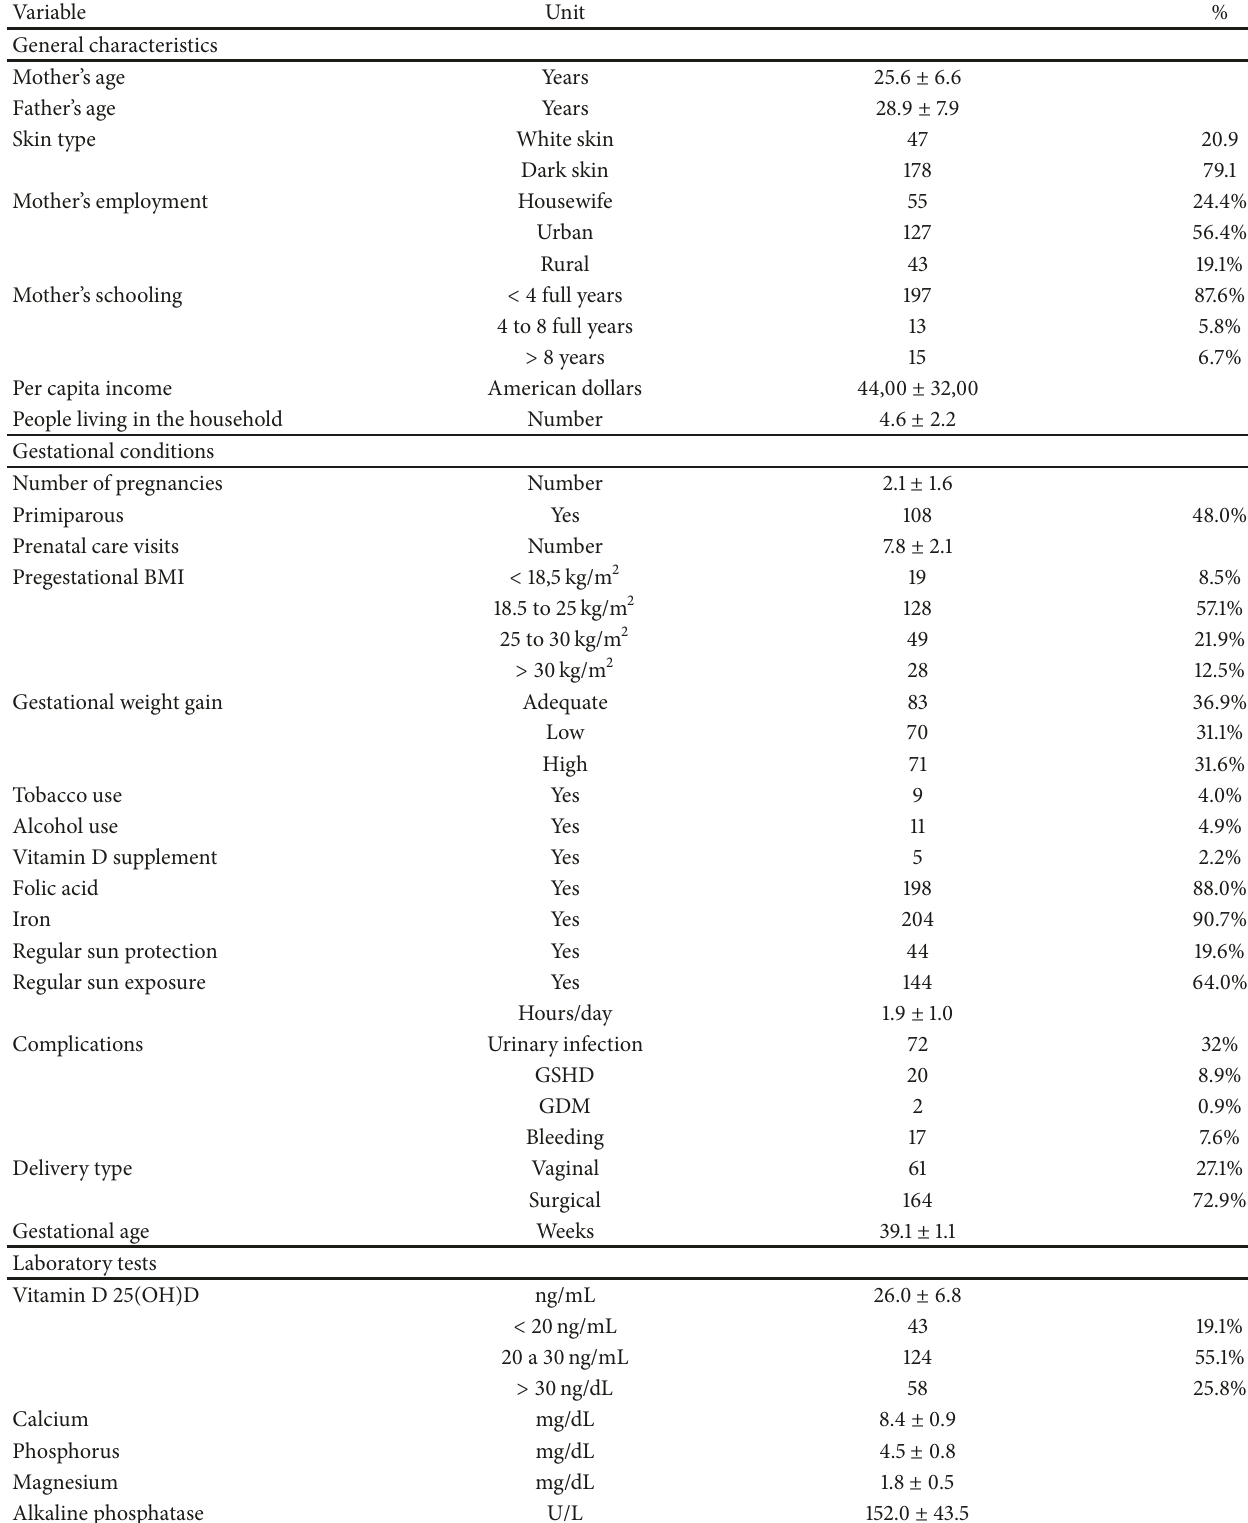
Table 1: Characterization of women included in the study (n =